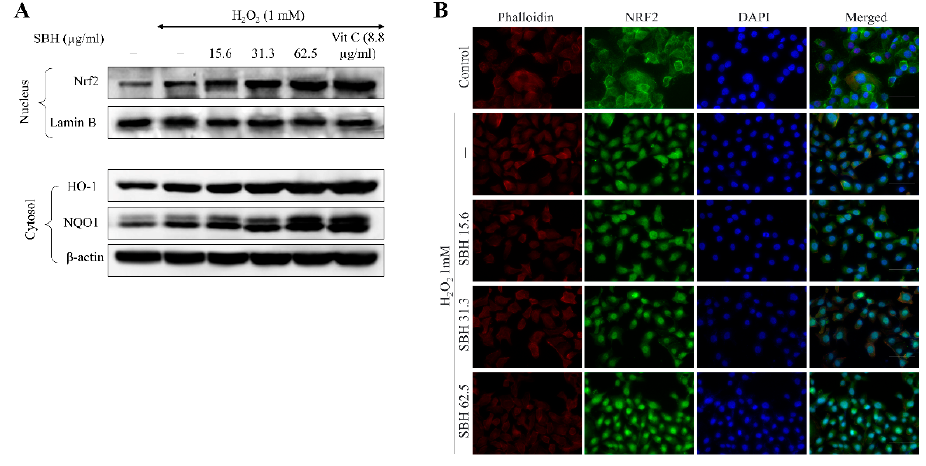
Figure 6. Effects of SBH in increasing the activation of Nrf2/HO-1/NQO1 signaling pathway in H 2 O 2 - induced Vero cells. ( A ) Western blot analysis and ( B ) immunofluorescence analysis of Nrf2 nuclear translocation. Experiments were carried out in triplicate (n = 3) to ensure repeatability.3.8. SBH sup- pressed NF- κ B and MAPK signaling in H 2 O 2 -induced Vero cells.